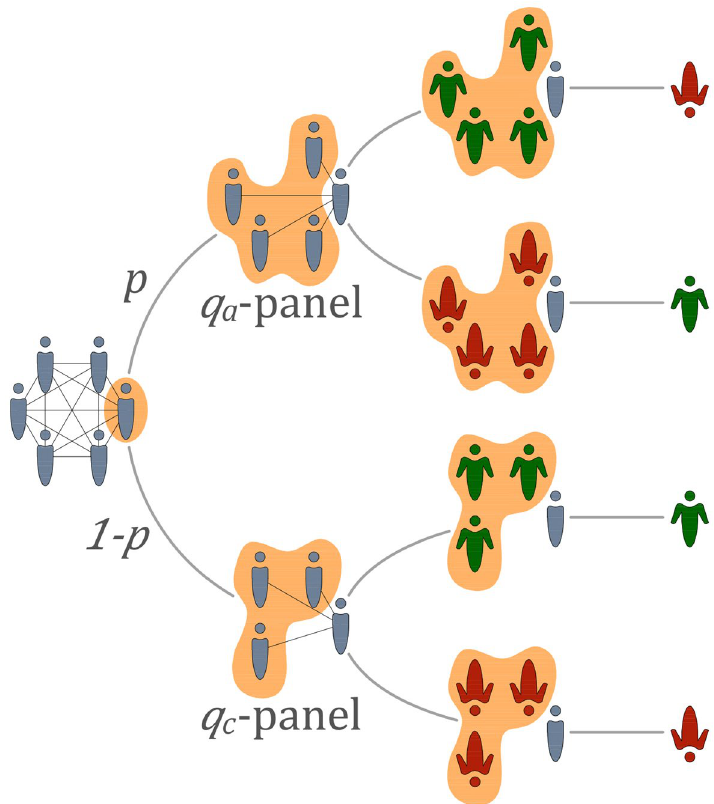
Figure 1. Schematic illustration of a single model’s update. First, a target voter is chosen randomly and then with probability p it acts as an anticonformist, whereas with probability 1 − p as a conformist. In the first case (the upper branch in the plot), the source group of q a agents is chosen from the neighborhood ( q a -panel) of the target voter and if they are all in the same state then the active voter takes a state opposite to the q a -panel. In the second case (the bottom branch in the plot), the source group of q c agents is chosen from the neighborhood ( q c -panel) of the target voter and if they are all in the same state then the active voter takes a state of the q c